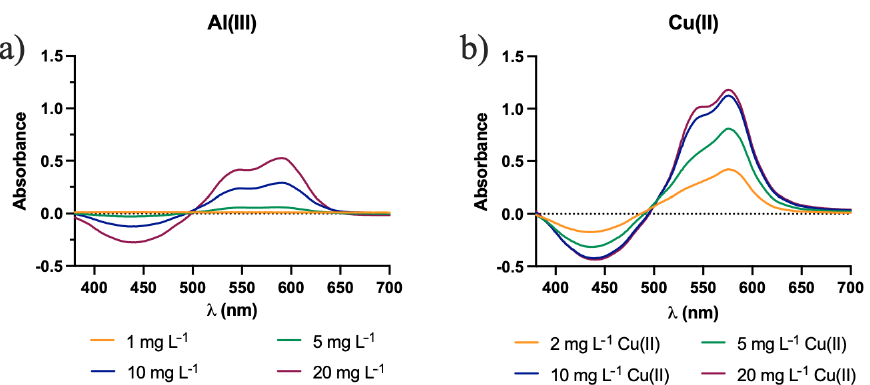
Figure 9. Graphical representation of the UV-Vis spectra of the membrane CH-CS after immersion in different concentrations of: ( a ) Al(III); ( b ) Cu(II).